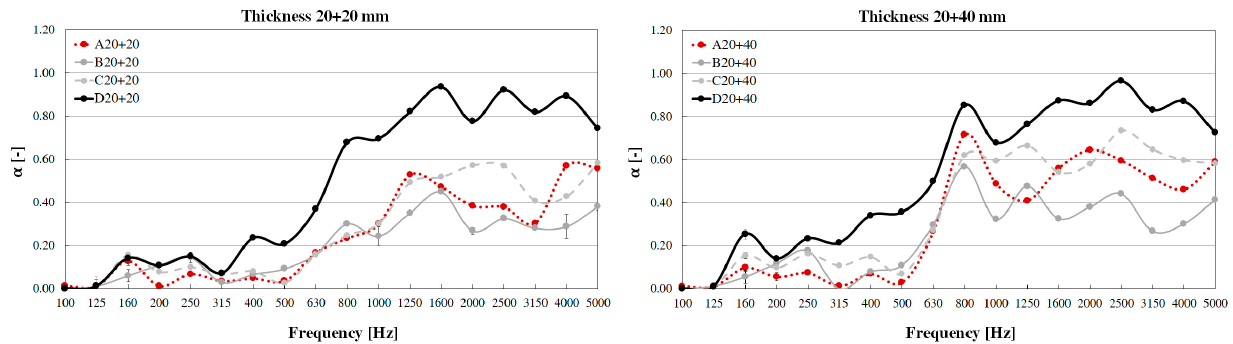
Figure A1. Comparison of the absorption coefficients for samples A–D with different thicknesses. Sample A: crushed normal weight aggregates 4–8 mm; Sample B: round lightweight aggregates 4–8 mm; Sample C: round lightweight aggre- gates 2–4 mm; Sample D: round lightweight aggregates 0.5–1 mm.